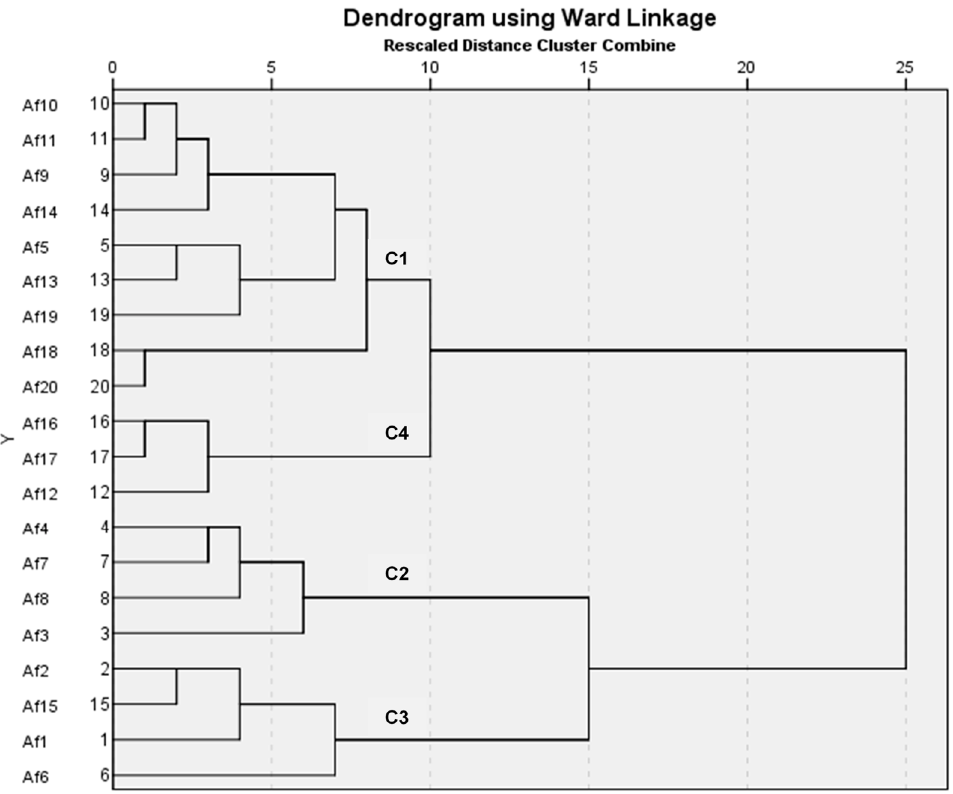
Figure 3. Dendrogram of the 20 alfalfa populations by analyzing traits using Ward cluster analysis